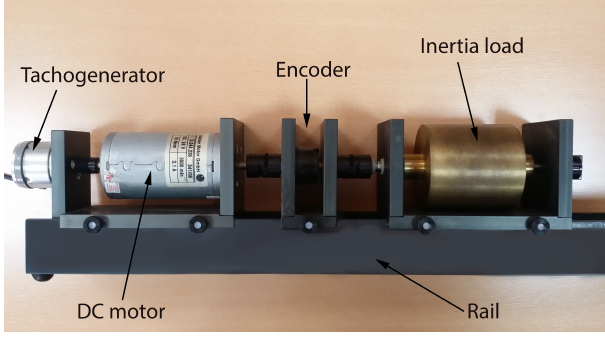
Figure 2: DC servo system